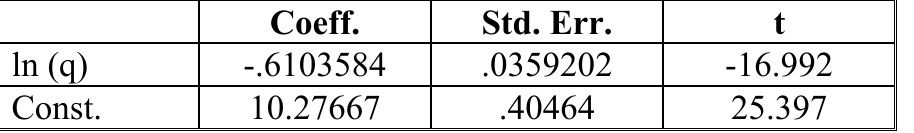
Results of estimating a constrained log-log demand function for tourists from non-African countries Coeff. Std. Err. t